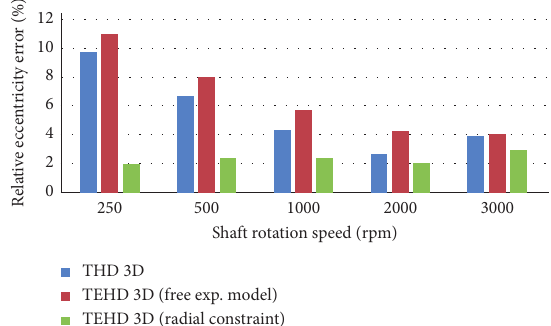
Figure 22: Difference between relative eccentricities measured and computed by means of 3D models for the modified RK in con- figuration